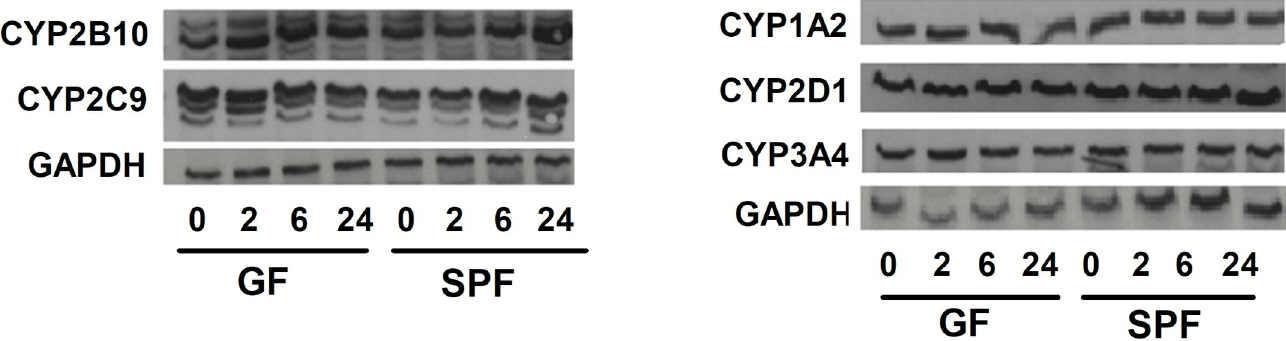
Fig 5. Protein expression of CYP enzymes. Protein expression was measured in pooled hepatic microsomal samples of four SPF and four GF mice (0 = control, and time 2h, 6h and 24h after application of metronidazole). Protein expression of CYP enzymes was normalized to the expression of GAPDH.